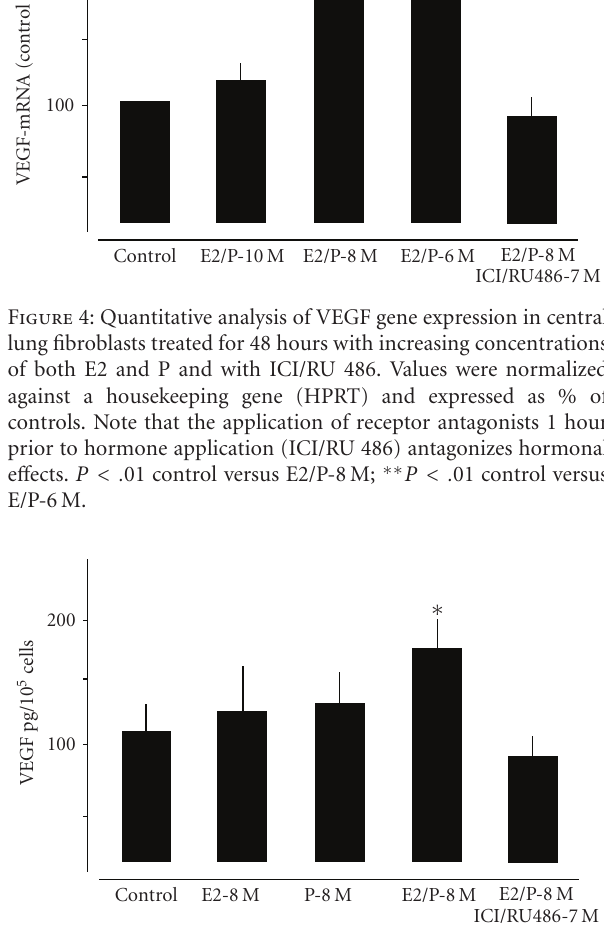
Figure 5: Quantification of VEGF protein release of lung fibroblasts treated for 48 hours with E2-8M and P-8M alone or in combina- tion determined by ELISA. Note that corresponding with results obtained by gene expression analysis (Figure 3) VEGF protein is increased in central lung fibroblast cultures only by combined treatment with E2 and P. Pretreatment with ICI/RU 486 abrogated this e ff ect. ∗ P < . 05 control versus